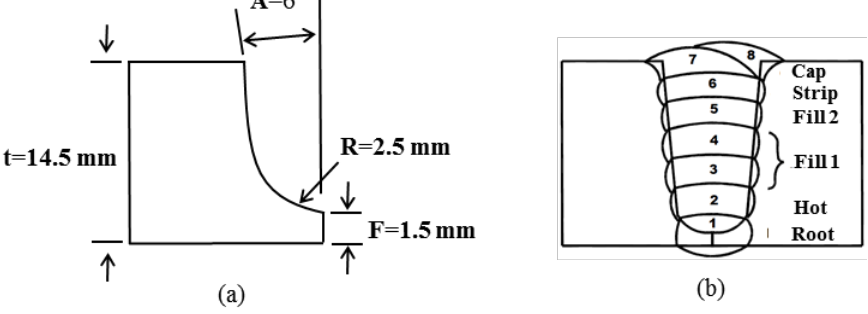
Figure 15. Moving averaged signal (voltage).